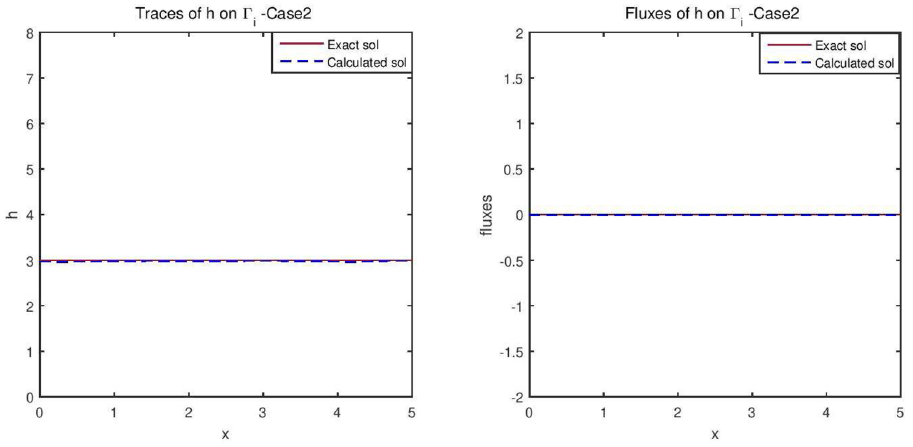
Figure 5. The reconstructed flow—Case